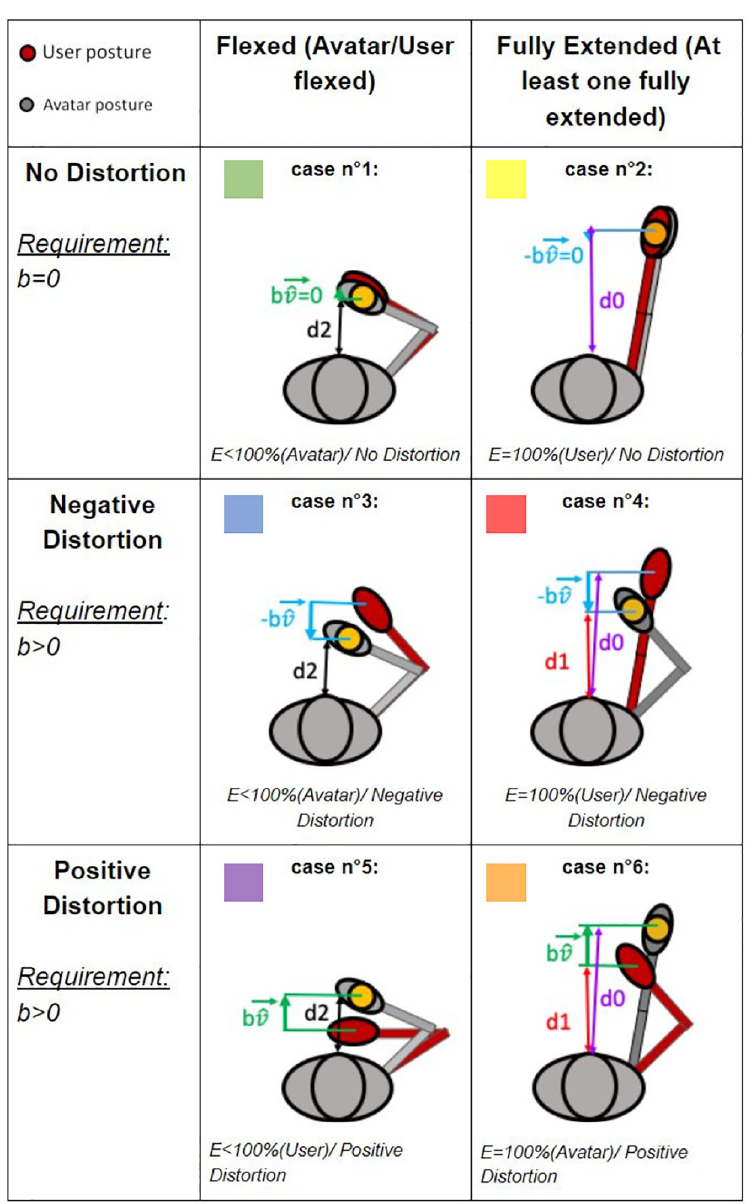
Fig 3. Movement distortion in the six conditions. The avatar is in grey, the subject in red, and the target in yellow; d0 represents the distance between the torso and the target when no distortion in the fully extended condition; d1 represents the distance between the torso and the hand for the flexed arm (virtual or real) when distortion in the fully extended condition; d2 represents the distance between the torso and the target when no distortion in the flexed condition. In flexed conditions, the avatar always covers the distance d2, contrary to the subject who covers a difference distance in distorted conditions. In full extension, either the avatar covers a shorter distance d1 than the subject who covers d0 (case 4), or the opposite happens (case